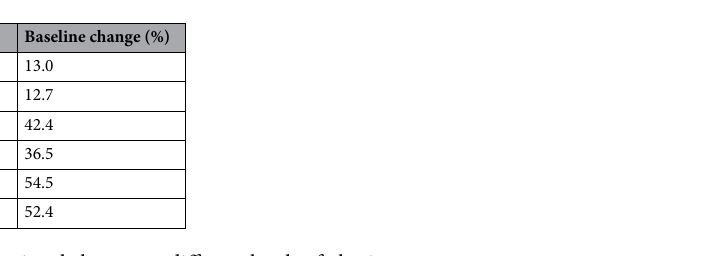
Table 4. Waveform baseline signal changes at different levels of obesity.